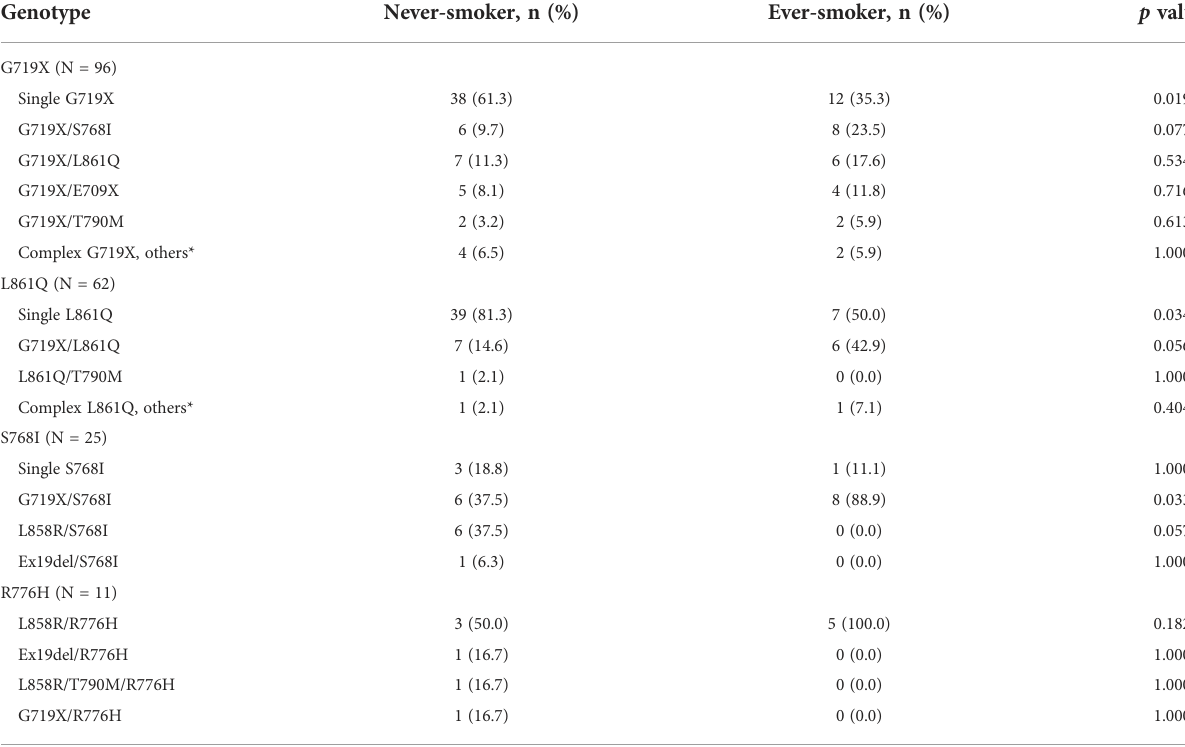
TABLE 5 Frequency of speci fi c genotypes of uncommon EGFR mutation in never- and ever-smokers.